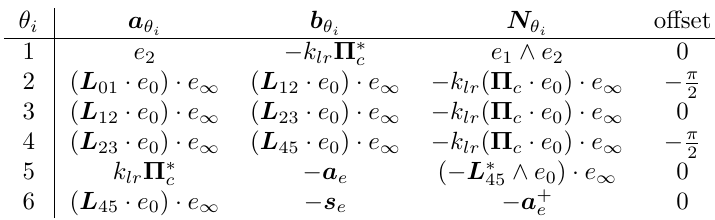
Table 4: Joint angle parameters for the UR5 robot. It can be verified that the dual of ˆ N θ z i − 1 of the Denavit-Hartenberg convention. Note that the table shows the non-normalized bivectors N θ . i